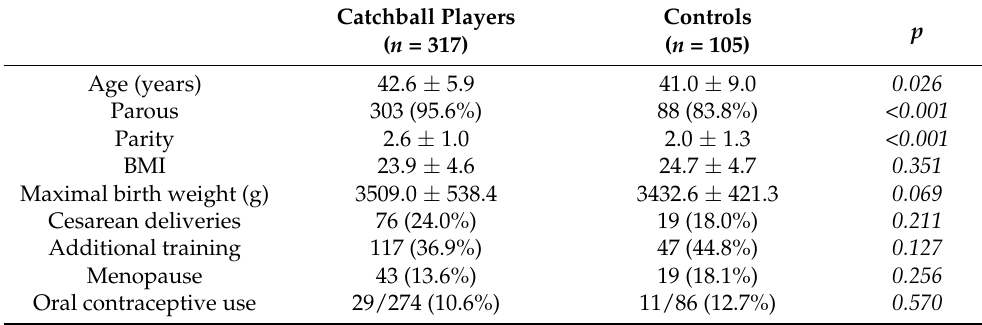
Table 1. Demographic